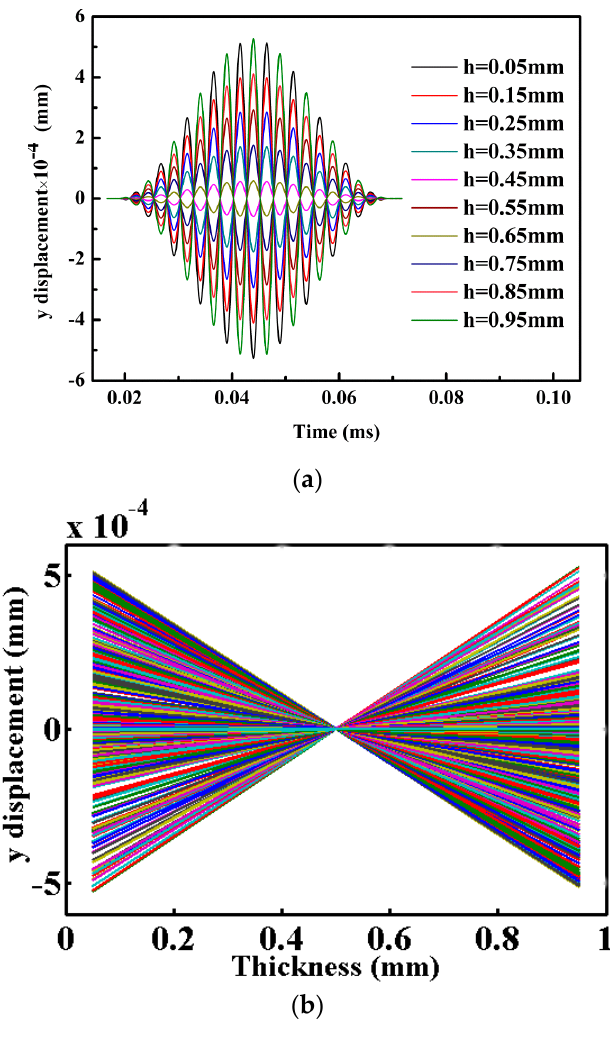
Figure 6. ( a ) Displacement in y -axis direction at different locations through-thickness direction with the same x coordinate (=100 mm); ( b ) S 0 mode at 200 kHz—through thickness profiles for y displacement at x coordinate (=100 mm) for various times t = 0.02–0.07 ms. Table 2. Group velocity verification for symmetric (S 0 ) and antisymmetric (A 0 ) mode Lamb waves at center frequencies of 100 kHz and 200